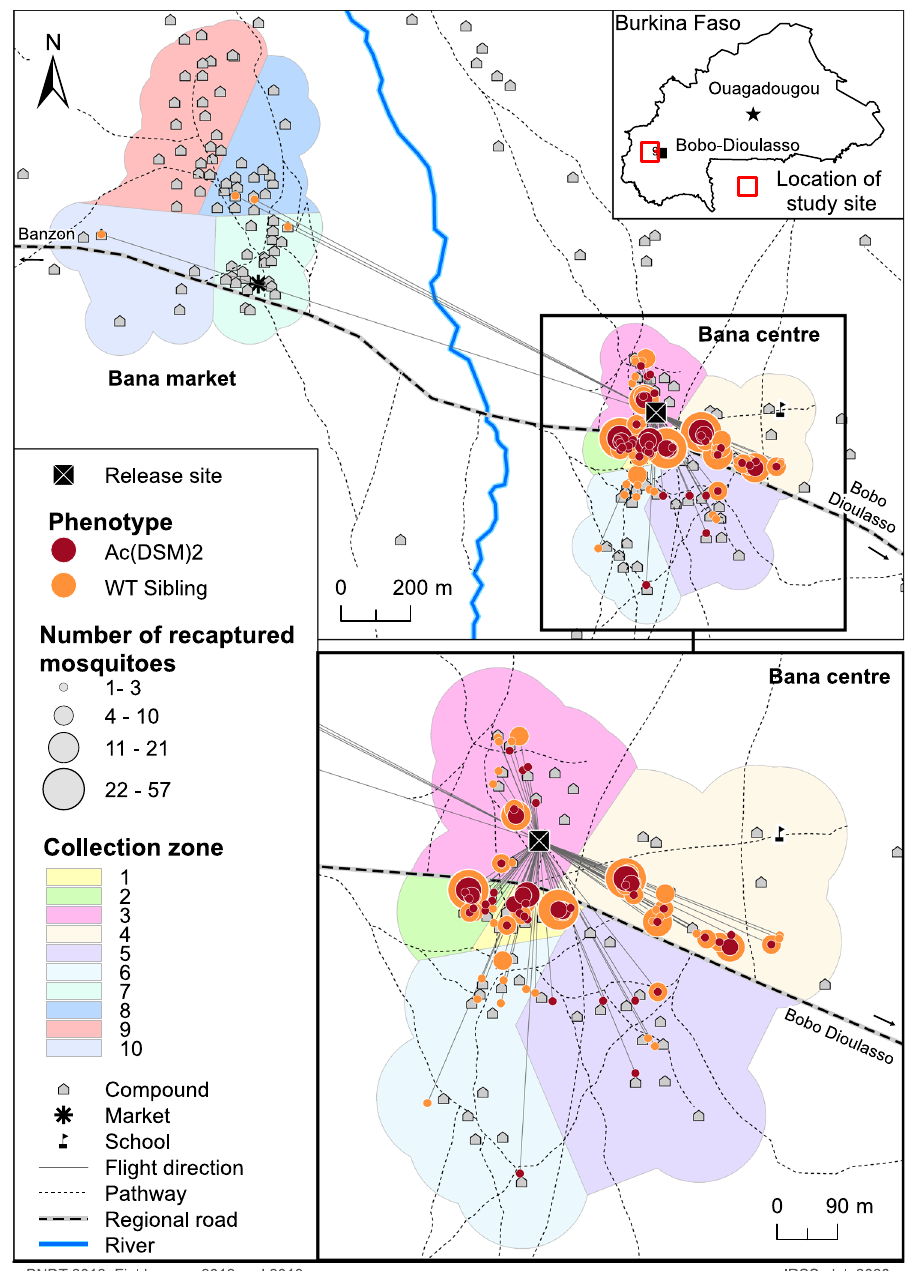
Fig. 1 Dispersal of the released mosquitoes within the study village of Bana. across the villages of Bana Centre and Bana Market and within Bana Centre where the small release was conducted and most marked-males recaptures were made. (Ac(DSM)2: Anopheles coluzzii Dominant Sterile Male; WT sibling: Wild type sibling) (Map drawn using Arc GIS, version